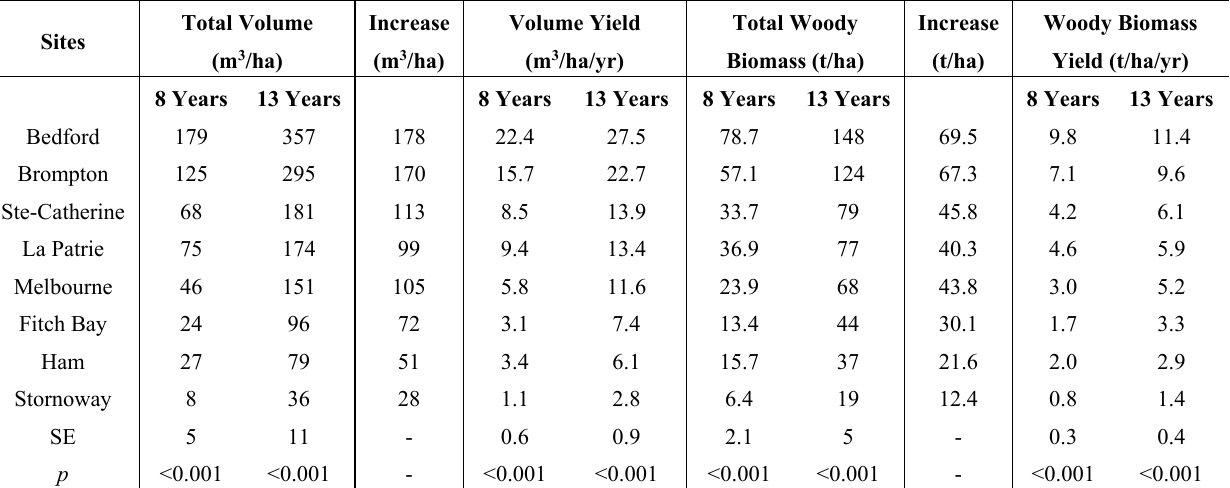
Table 7. Site effect for total stem volume and woody biomass production and mean annual volume and biomass yield for 8 and 13 year-old poplar plantations. The volume and biomass increases from year 8 to 13 is indicated. Data for 8 year-old plantations were taken from Truax et al.